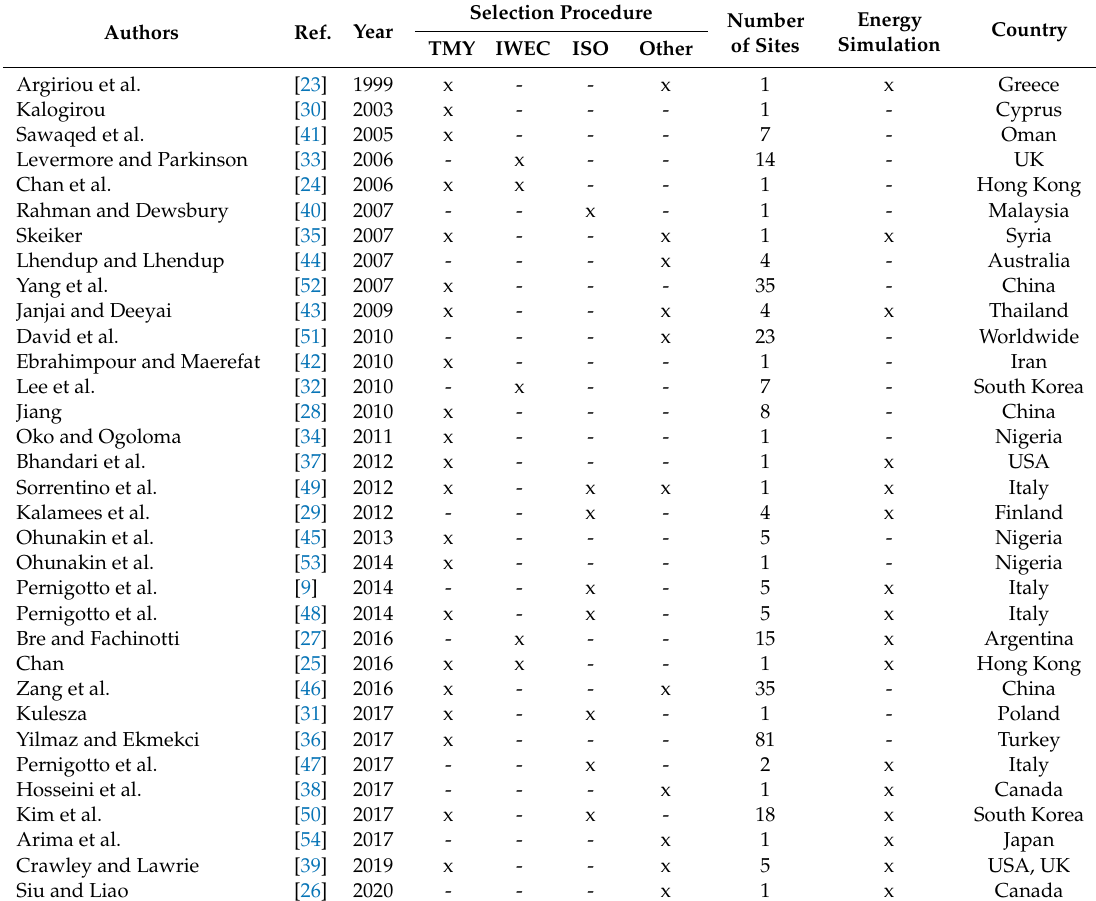
Table 1. Papers dealing with the typical weather year (TWY) generation and their e ff ect on building energy